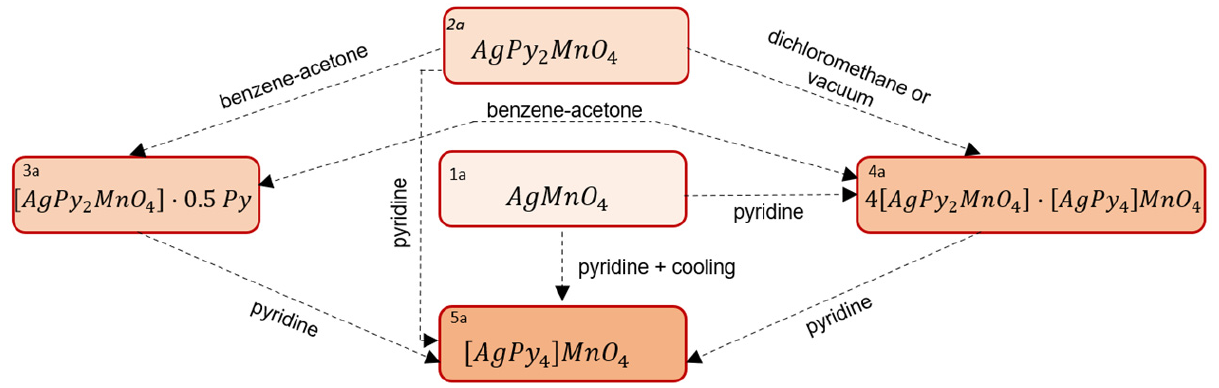
Figure 1. Interconversion scheme of permanganate complexes [8].